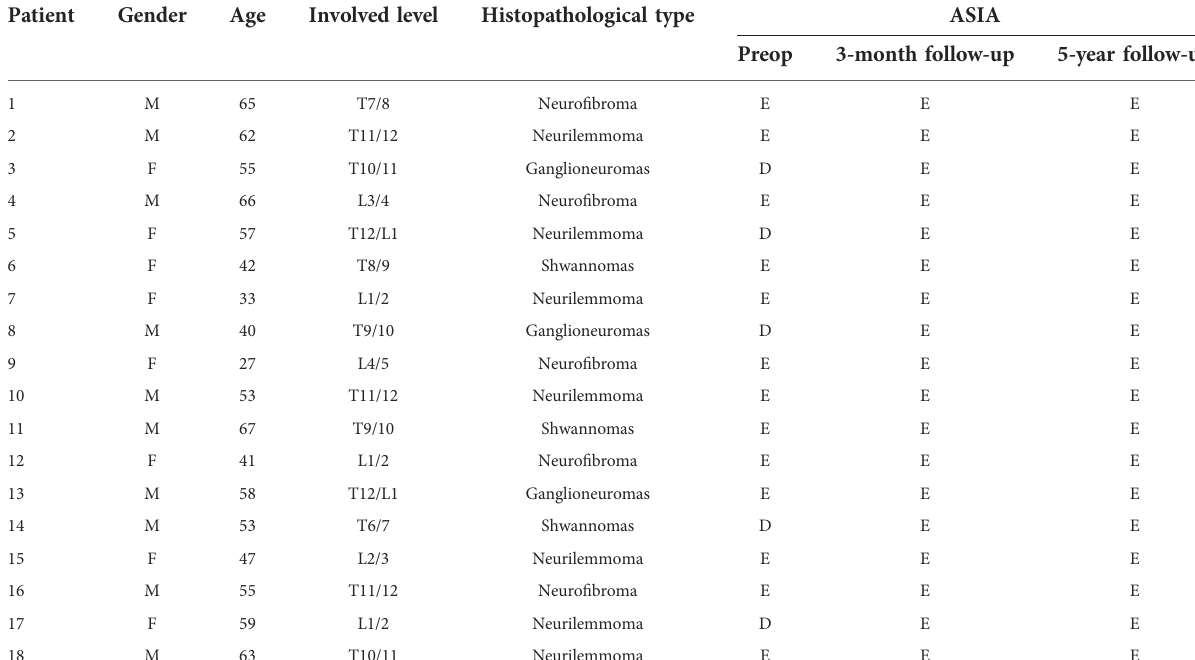
TABLE 2 Results of patients treated via traditional open surgical